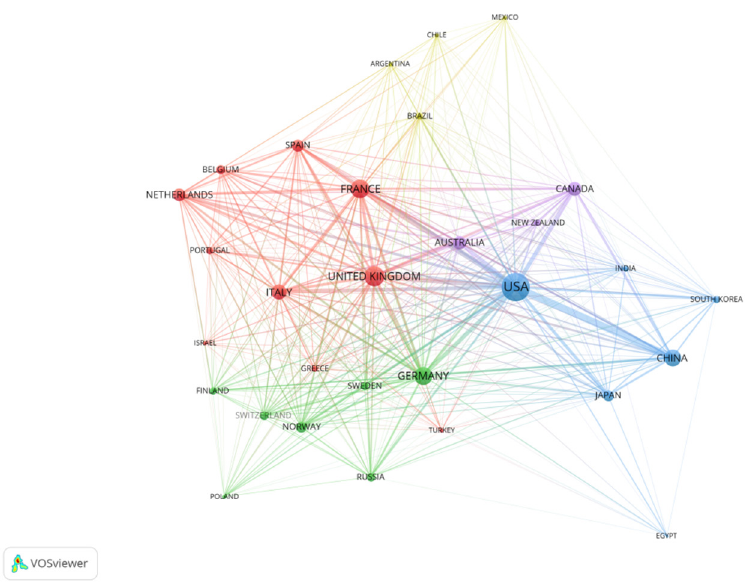
Figure 3. The cooperation network of the productive countries. Table 2. Top 20 institutions based on total